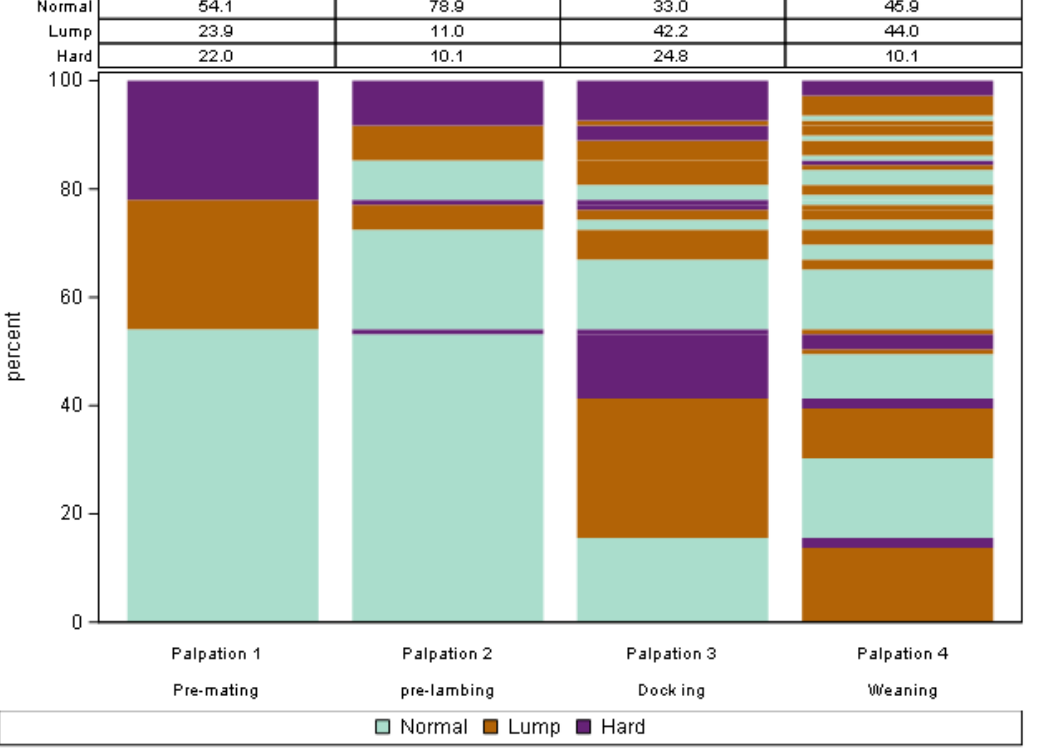
Figure A2. Lasagna plot of palpable udder half defects (hard, lump, and normal) from non ‐ dairy Romney ewes identified during udder examination events occurring at key management times (pre ‐ mating, pre ‐ lambing, docking, and weaning; Study A). Lasagna plot of 109 udder halves in the year 2018, excluding udder halves observed with no udder defect on all occasions. Note: Within each plot, each bar shows a different udder half scoring event (i.e., time) while the different colours within each bar represent the defect categories. The data in the table at the top of each plot designates the percentage (%) of each udder half defect category at each event, which corresponds to the percentage of each colour at each event. Change in defect category over time of each udder half can be tracked by following longitudinal transitions across the udder scoring events of stacked bars.